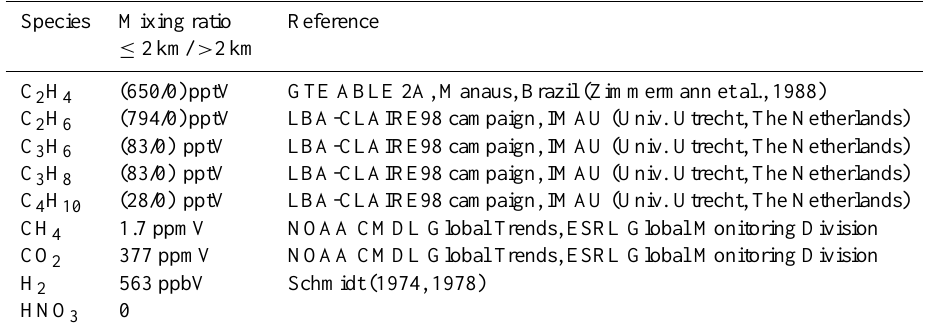
Mixing ratios of species which were not measured during the GABRIEL campaign and were fixed for simulation (ppmV=10 − 6 · mol , ppbV=10 − 9 · mol , pptV=10 − 12 · mol ). Mixing ratios of alkanes and alkenes were set to zero for altitudes > 2km, mol mol mol except for CH 4 . Table taken from Stickler et al.